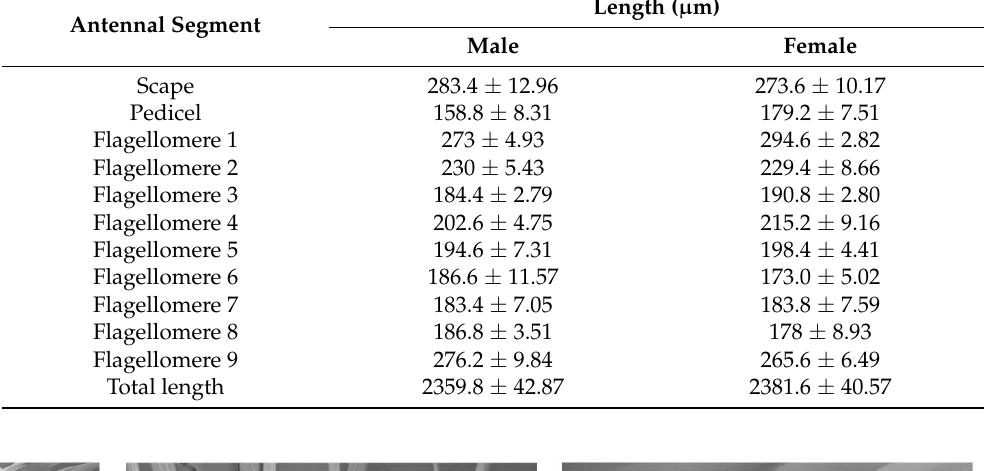
Table 2. Scape, pedicel, and flagellomeres lengths (mean ± SE) of adult O. communa antennae.